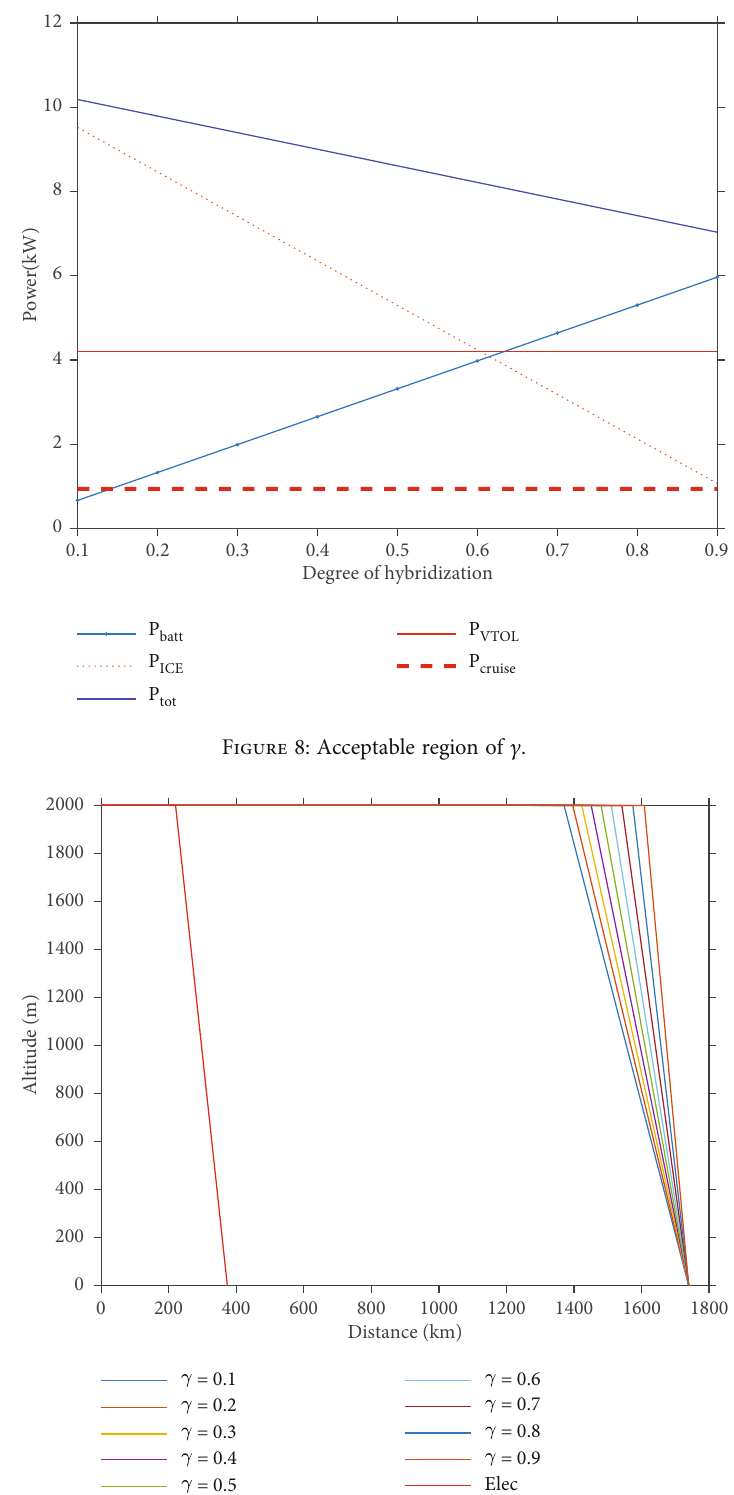
Figure 9: Di ff erent areas of the mission pro fi